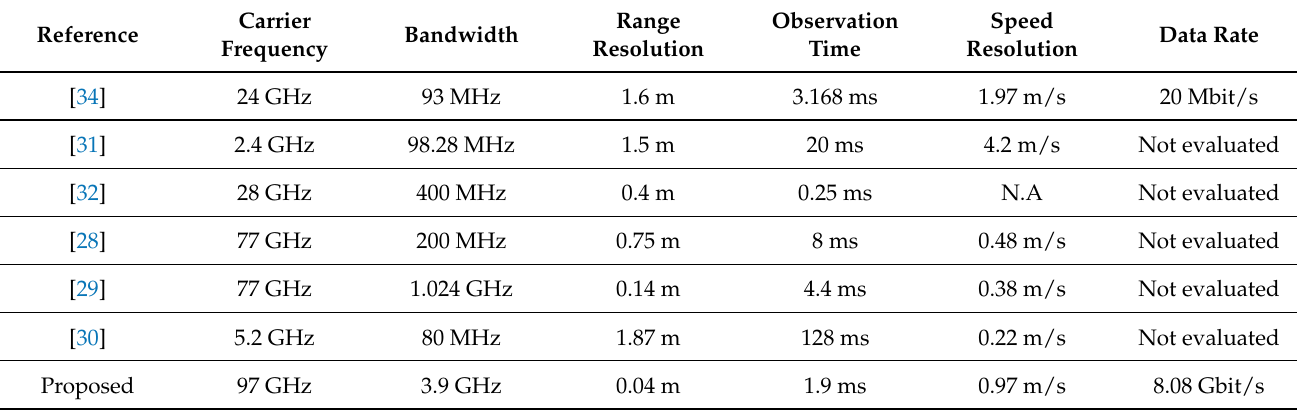
Table 4. Performance comparison of the proposed converged system with the existing